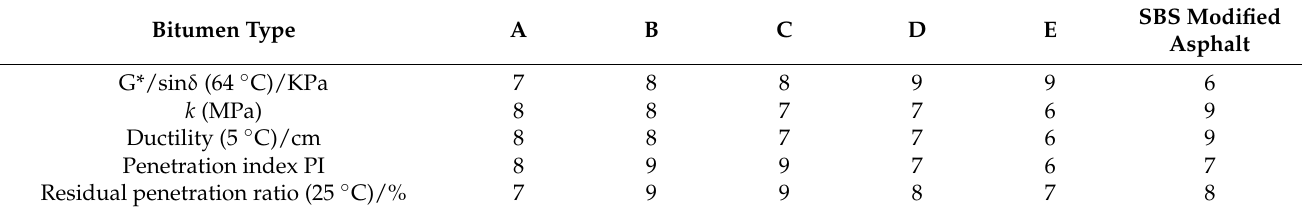
Table 9. Scores for each modified asphalt